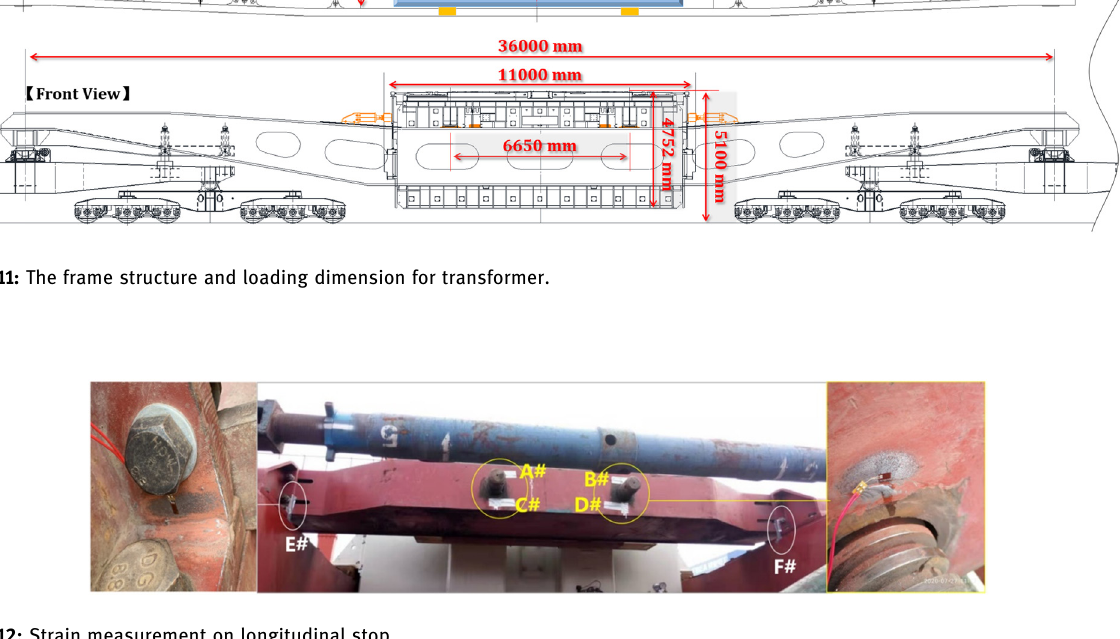
Figure 12: Strain measurement on longitudinal